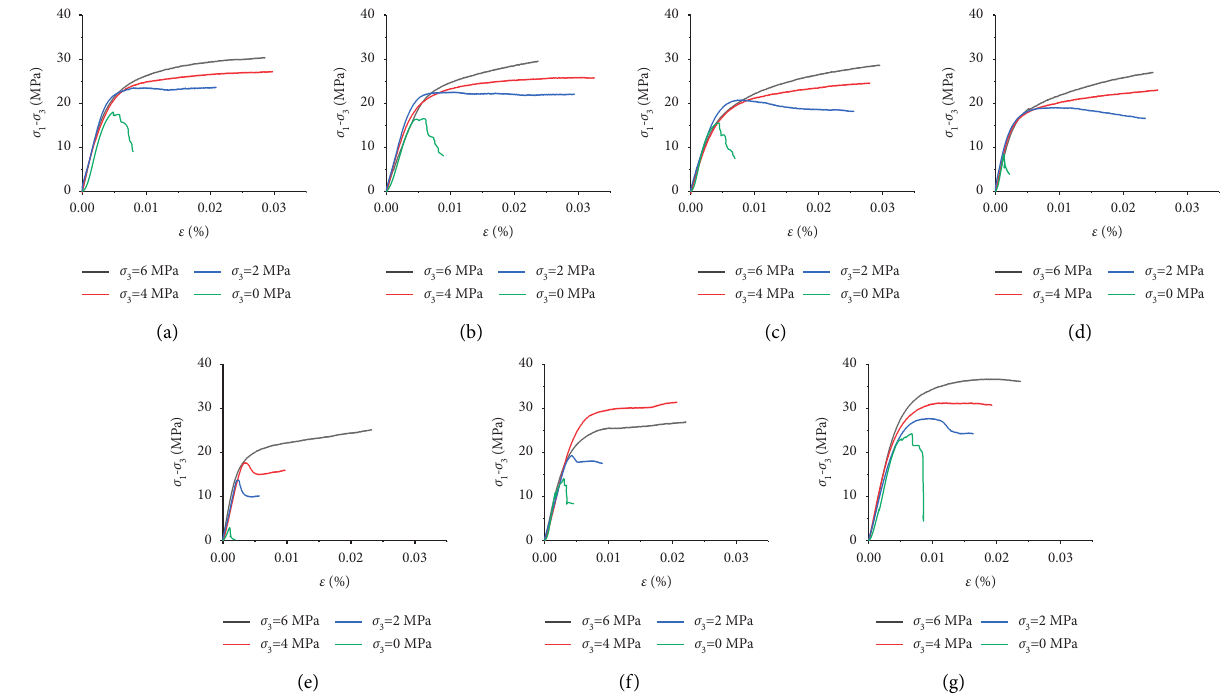
Figure 7: Stress-strain curves of Group AB layered composite rock under triaxial compression: (a) β � 0 ° , (b) β � 15 ° , (c) β � 30 ° , (d) β � 45 ° , (e) β � 60 ° , (f) β � 75 ° , and (g) β � 90 °